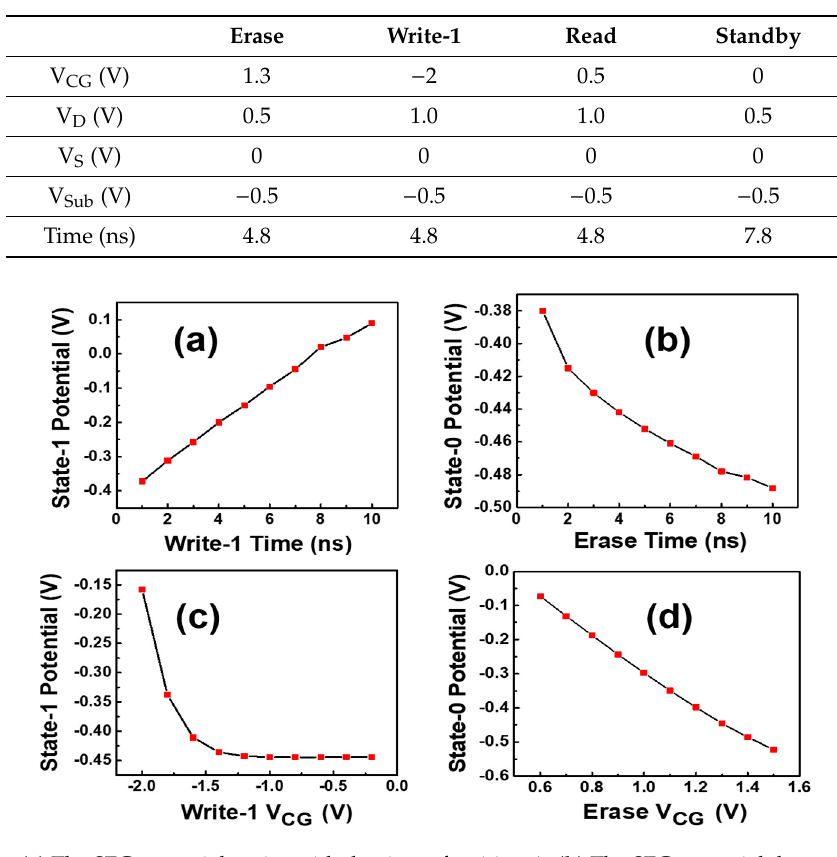
Figure 3. ( a ) The SFG potential varies with the time of writing-1. ( b ) The SFG potential decreases as the erasing time increases. ( c ) The SFG potential varies with V CG during writing-1 with 4.8 ns operation time. ( d ) The SFG potential of state 0 decreases as V CG increases during the erasing